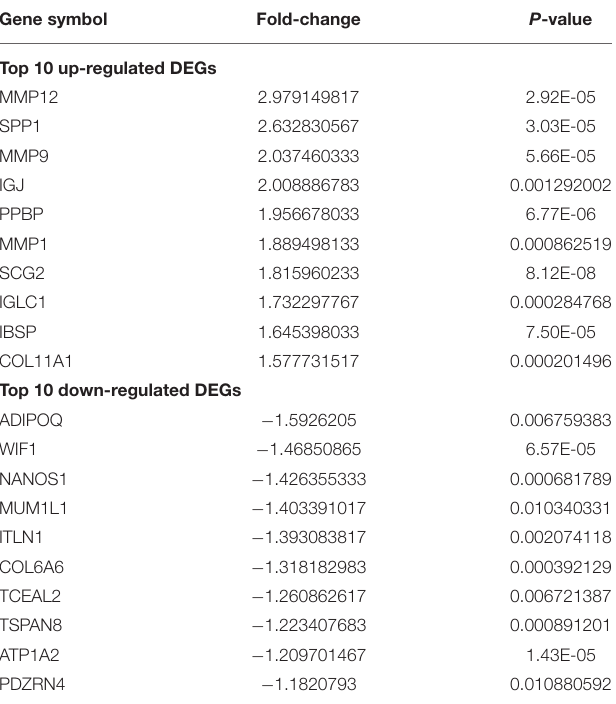
TABLE 1 | The top 10 up- and down-regulated DEGs in AVC and normal sample. Gene symbol Fold-change P -value